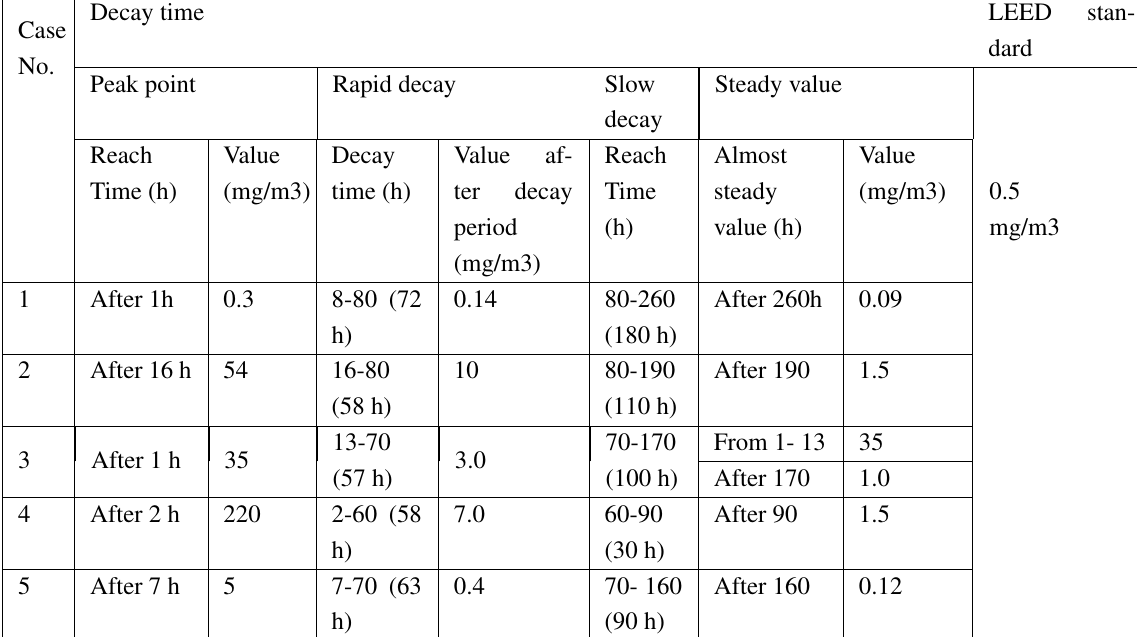
Table 4. The analysis of TVOCs concentration during the simulation period for each